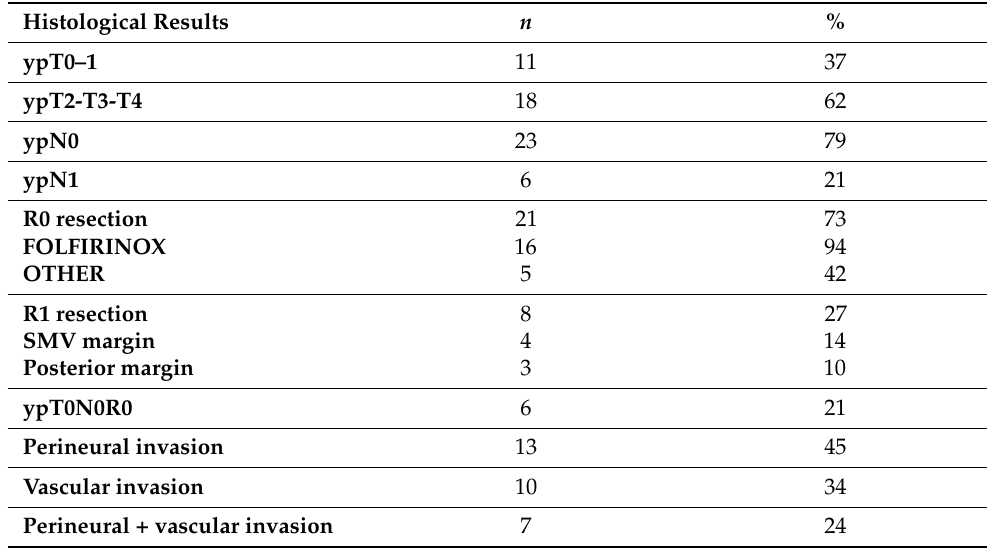
Table 4. Post-operative histological